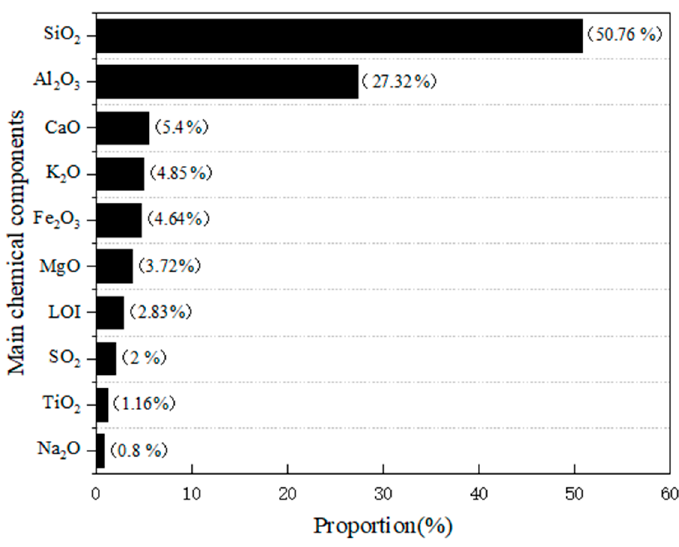
Figure 1. Chemical composition of fly ash (%).